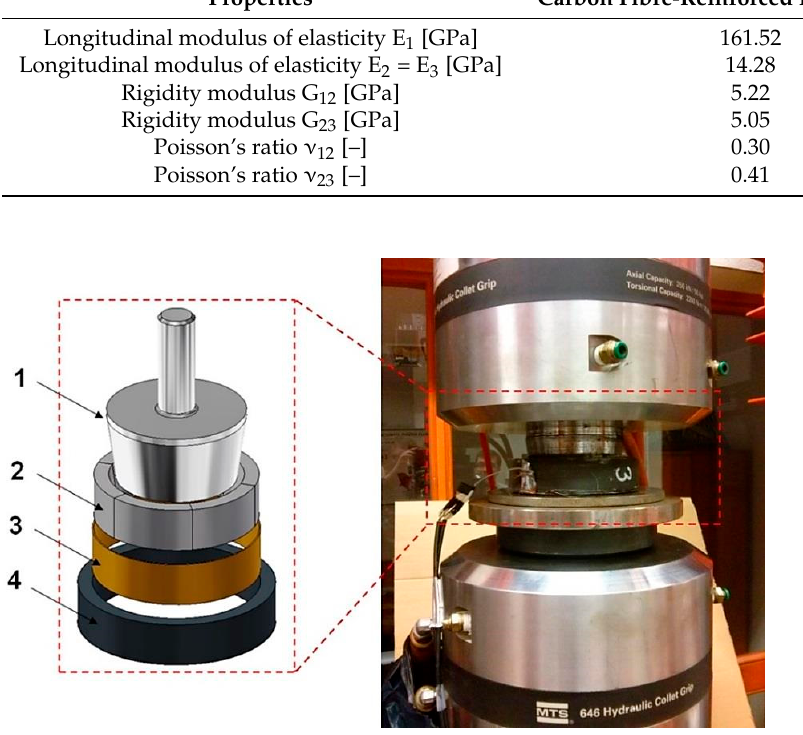
Figure 13. Strength test ring.